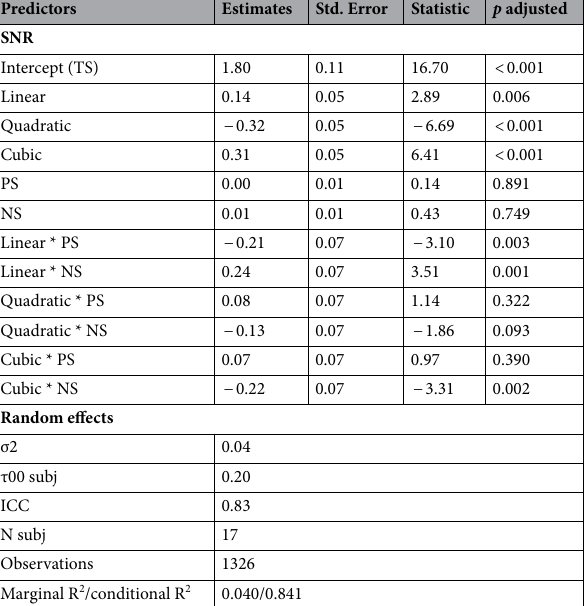
Effect of morpheme status. The comparison between the TS and NS conditions (solid vs. dotted line, Fig. 2) revealed a significant effect on the intercept ( b = − 0.07, t = − 4.74, p < 0.001), with a negative β, indicating that conditions. There was a significant effect on the quadratic term ( b = 0.24, t = 3.36, p = 0.002), with a positive β indicating a flatter curve in the NS compared to the TS condition, and therefore, a response that changed faster in the TS compared to the NS condition. The comparison between the TS and PS conditions (solid vs. dashed line, Fig. 2) revealed a significant effect on